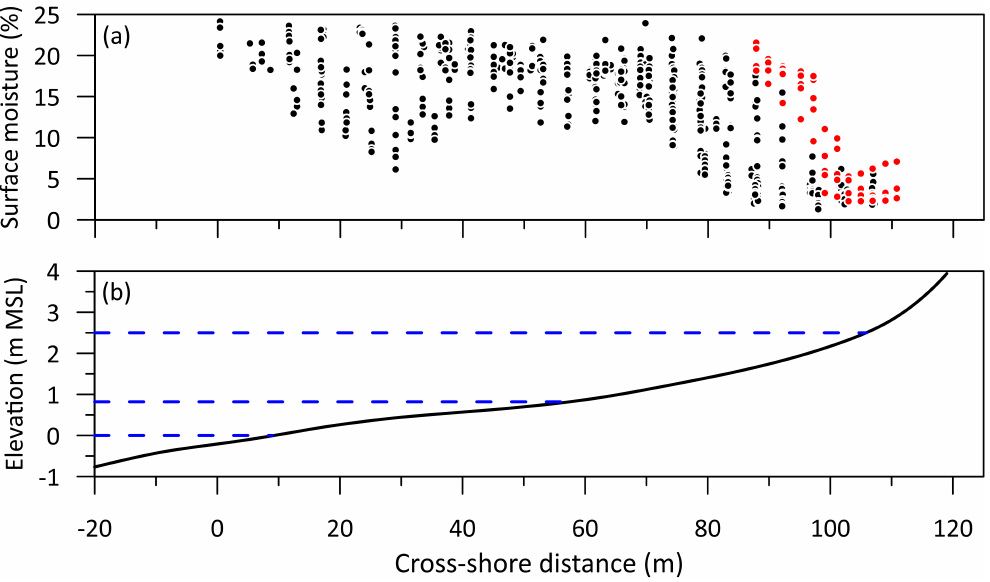
Figure 9. ( a ) Surface moisture content w s versus cross-shore distance x based on all measurement days (848 observations). The observations made on 6 October (immediately after the first storm) are shown in red. ( b ) shows the campaign-averaged cross-shore profile. The blue dashed lines are (from bottom to top) mean sea level, the normal mean high-tide level and the maximum total water level on 6 October.